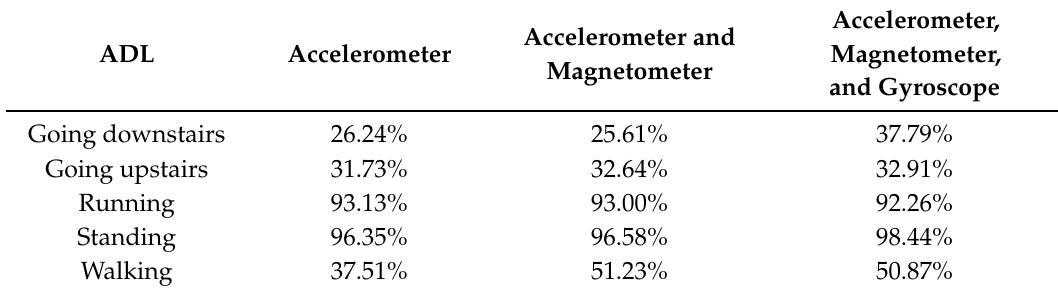
Table 3. Accuracies of ADL recognition using the AdaBoost with the decision stump method implemented with Weka software.